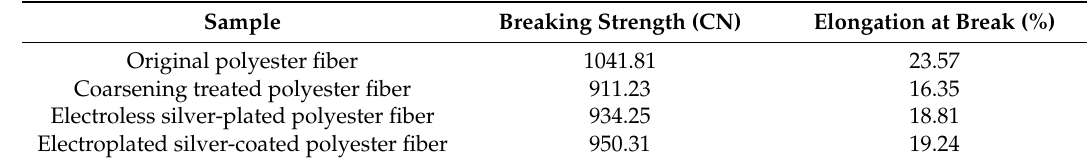
Table 1. Comparison of the mechanical properties of different fibers.